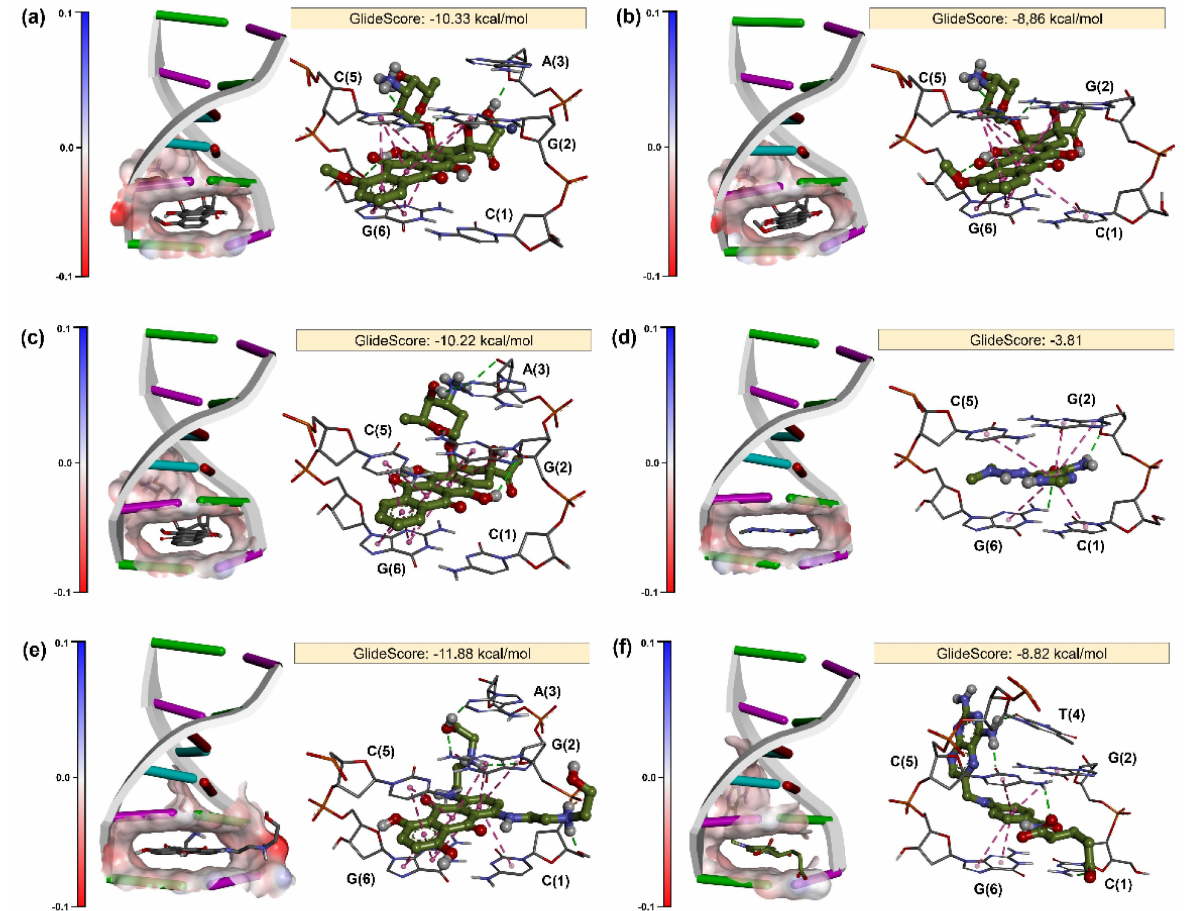
Figure 3. Structural basis for recognition of DOX ( a ), DAU ( b ), IDA ( c ), DAR ( d ), MIT ( e ), and MTX ( f ) by DNA hexamer (PDB ID: 1Z3F). The surface represents electron density mapping along the binding site of the DNA